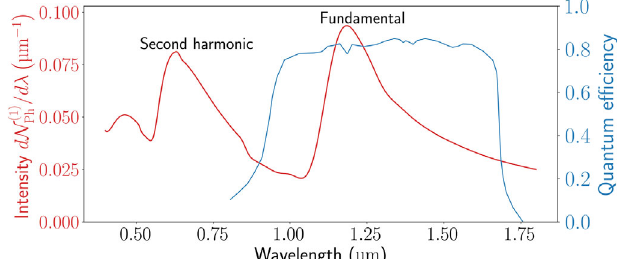
FIG. 4. Spectral distribution of the number of emitted photons (per electron) from the undulator in IOTA (red curve). Quantum efficiency of an InGaAs PIN photodiode (blue curve).